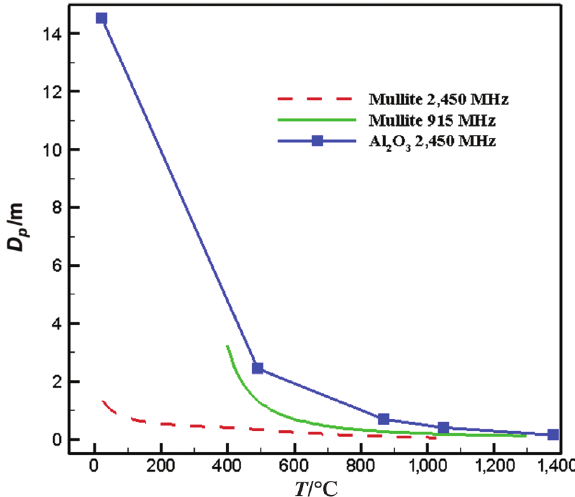
Figure 4: Temperature dependence of the microwave penetration depth of mullite and Al 2 O 3 ceramics.